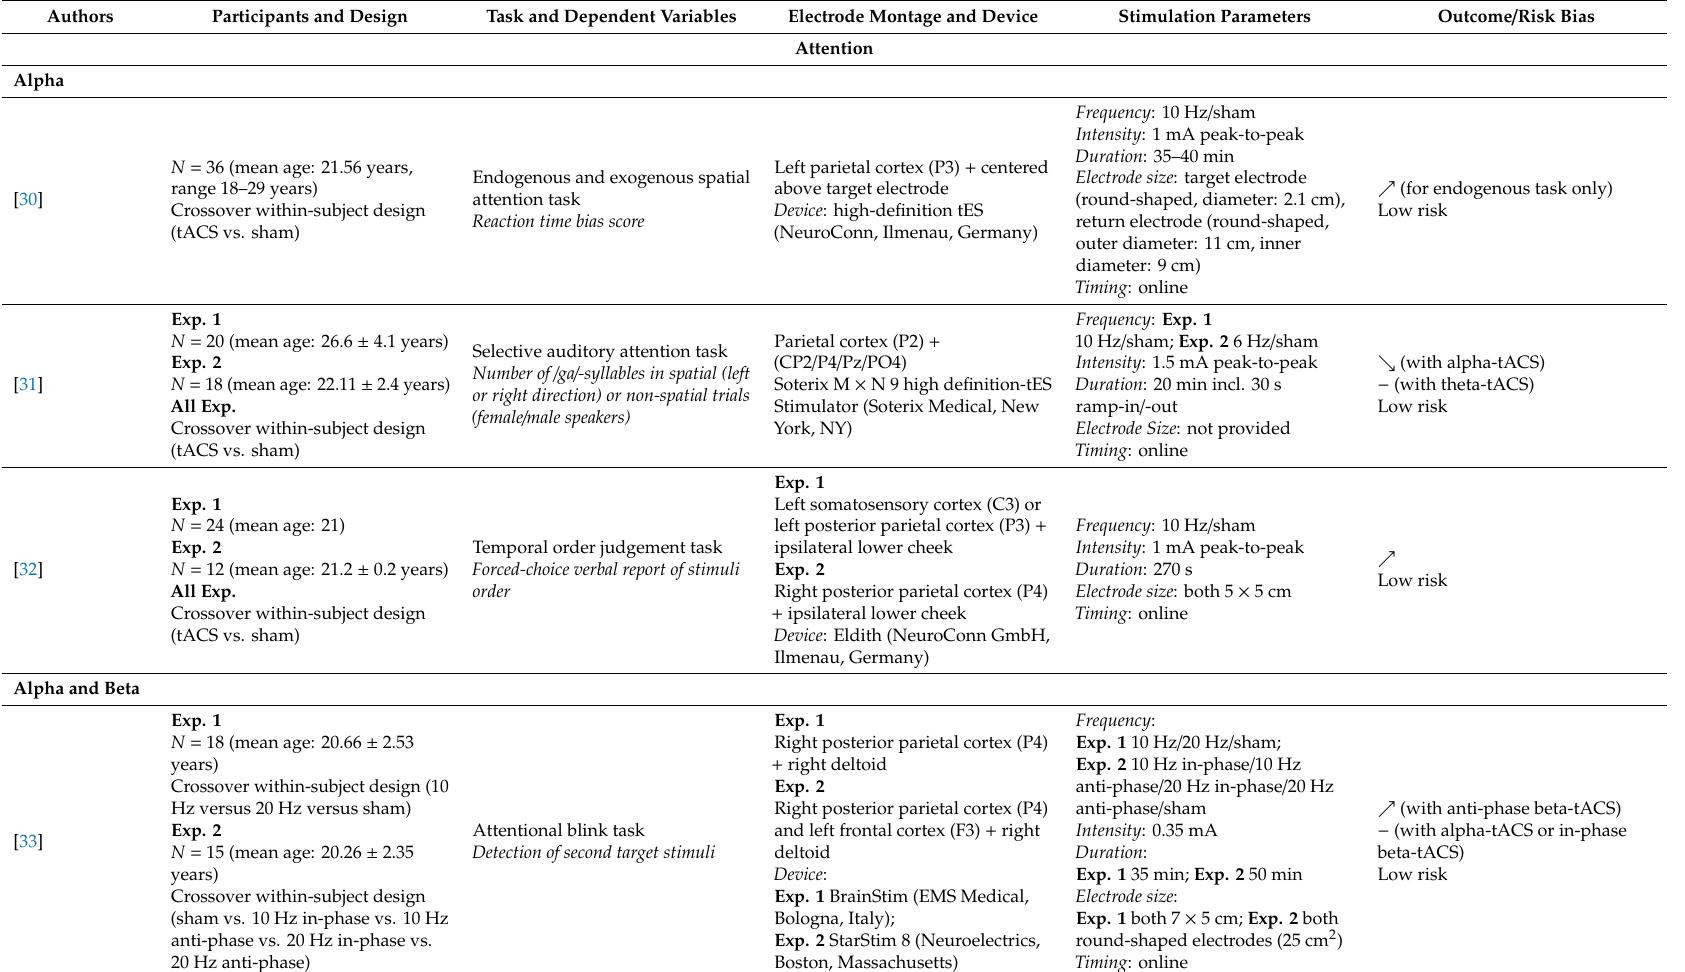
Table 1. Overview of study designs, tasks, stimulation parameters, electrode positions, as well as risk of bias for all included studies.